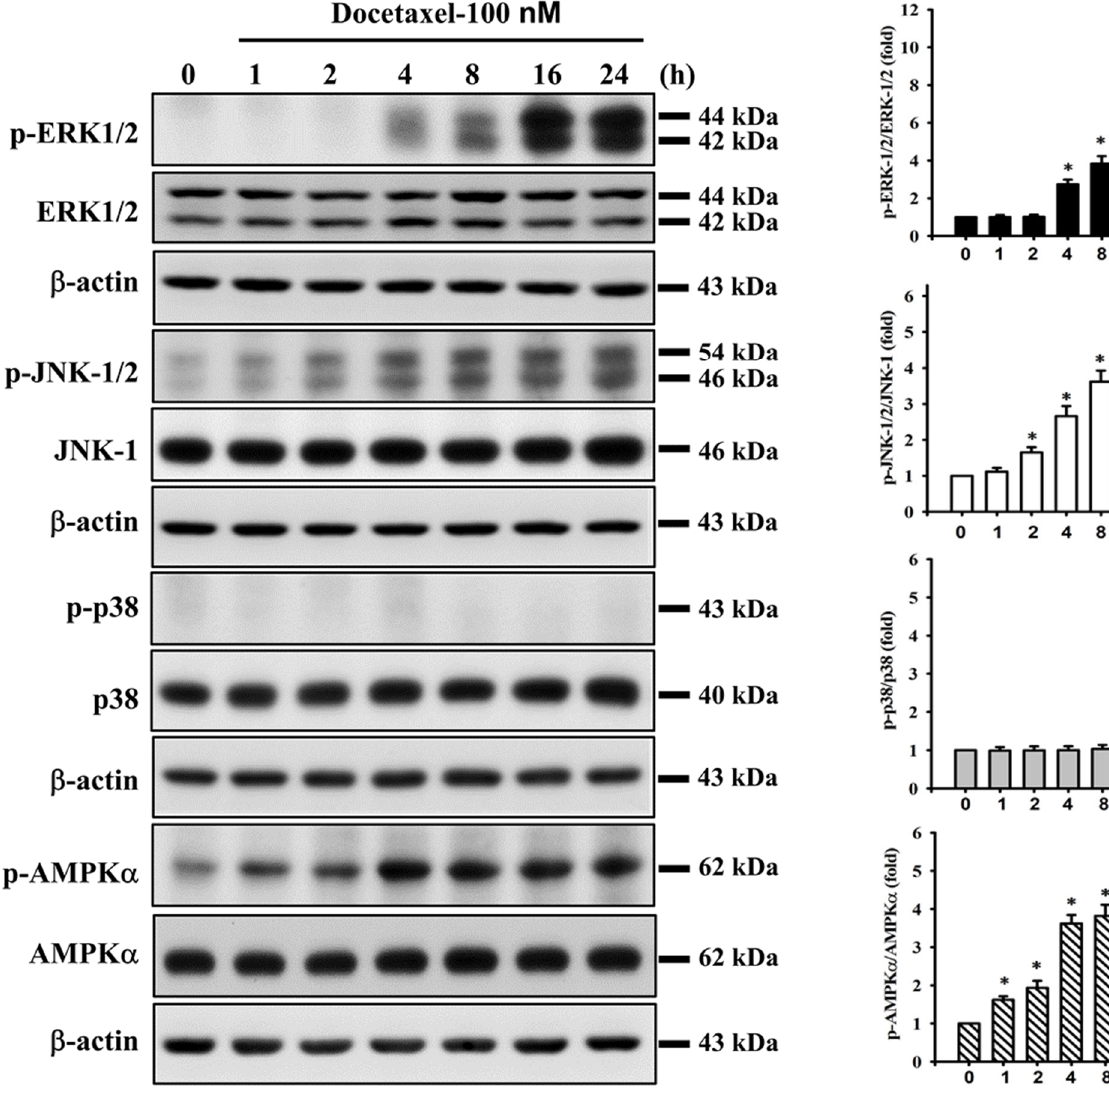
Figure 3. Effect of docetaxel on the protein expression for MAPK and AMPK signals in human tongue squamous carcinoma-derived SAS cells. Cells were treated with docetaxel (100 nM) for 1–24 h. The protein expression of phosphorylated (p)-ERK1/2, ERK, p-JNK1/2, JNK-1, p-p38, p38, p-AMPK α , and AMPK α was determined by Western blot analysis. Results are shown with representative images, and quantification was performed by densitometric analysis. Each presented bar is the mean ± SD of three independent experiments. Statistical analysis was performed with one-way ANOVA analysis followed by Tukey’s post hoc test. * p < 0.05 compared with vehicle control.